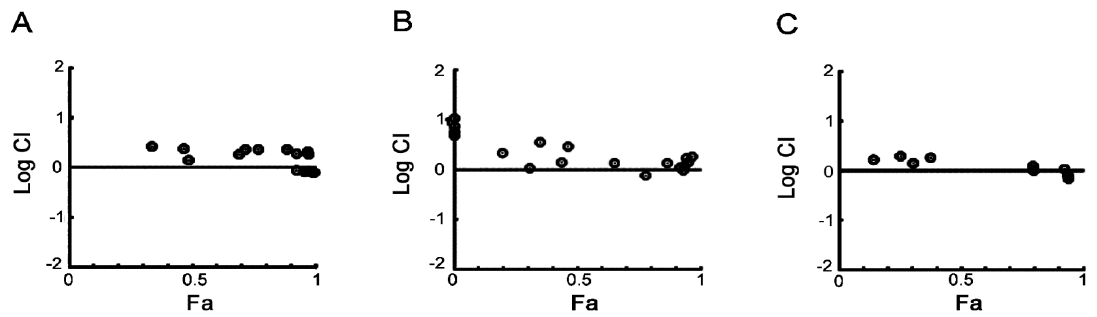
Figure 6. Combination Analysis of PHA-767491 using Chou-Talalay Median-Effect Equation. MM1S cells were treated with PHA-767491 alone and in combination with Melphalan (Range 2 to 32 µM, A ), Doxorubicin (Range 31 to 500 nM, B ) or Bortezomib (Range 1.3 to 20 nM, C ) in a non-constant ratio in a simultaneous fashion. Cell viability was examined by CellTiter Glo 48 h after drug treatment. Combination indices (CI) were calculated and the Log CI (circles) plotted in relation to the fraction of cells affected (Fa) at any given experimental